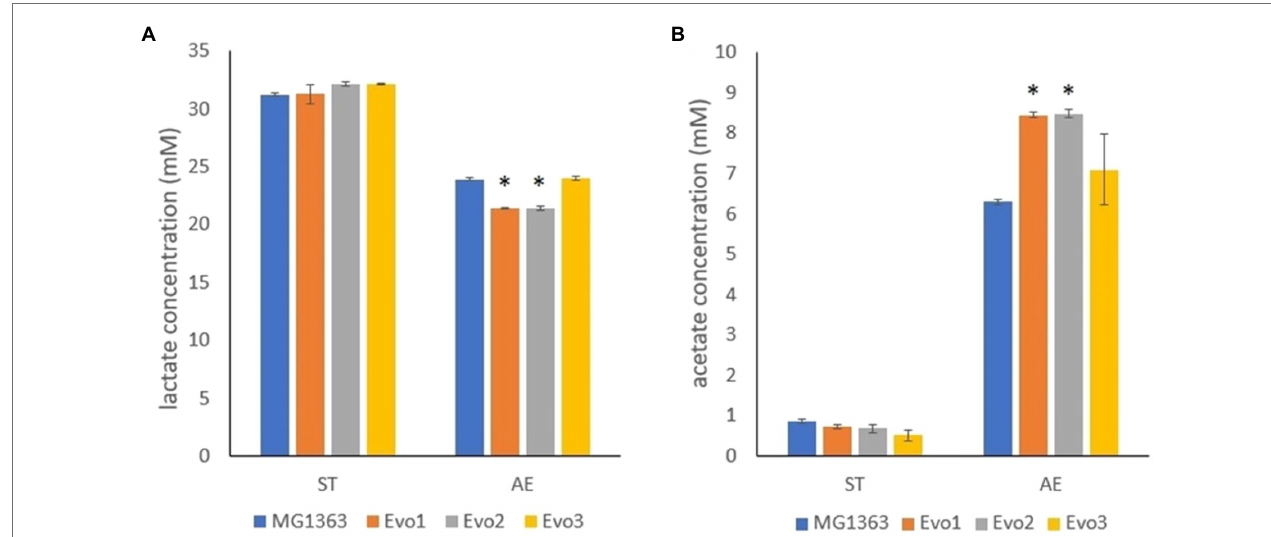
FIGURE 7 | Primary metabolites produced by MG1363 and evolved strains. (A) Lactate and (B) acetate concentration from the supernatant of cultures in GM17 at 30 ° C under indicated conditions. Data from three independent experiments, error bars represent SEM. * Indicates significant difference compared to MG1363 under the same condition ( p ≤